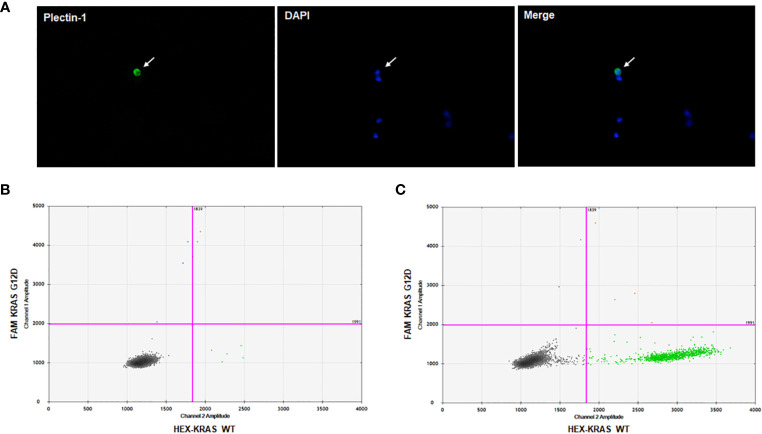
Plectin-1+ cell isolation and KRAS mutation analysis. To clarify Plectin-1-expressing cells in the blood, immunofluorescence staining was carried out to isolate Plectin-1-expressing cells, and ddPCR for KRAS wildtype (WT) and mutant (G12D) was performed. (A) A representative image of the circulating tumor cell (CTC) stained with Plectin-1 antibody (green) and 4’6-diamidino-2-phenylindole (DAPI) (blue). Arrow indicates the Plectin-1+ CTC. The detection of KRAS G12D mutation in (B) Plectin-1+ CTCs and (C) all capture cells on the microfabricated porous filter in the same patient.